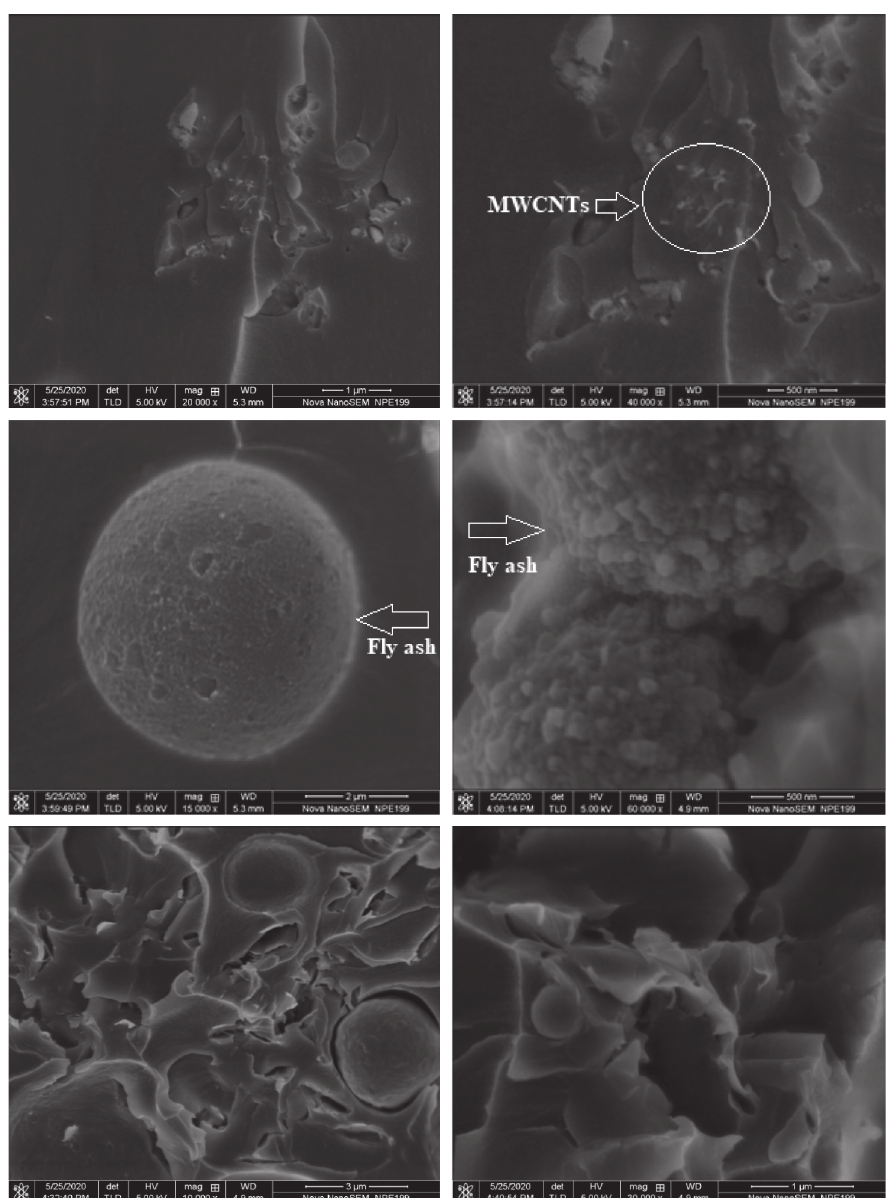
Figure 10: Image of the fractured surface structure of the coating with 1 wt.% MWCNTs, 10 wt.% FA in different